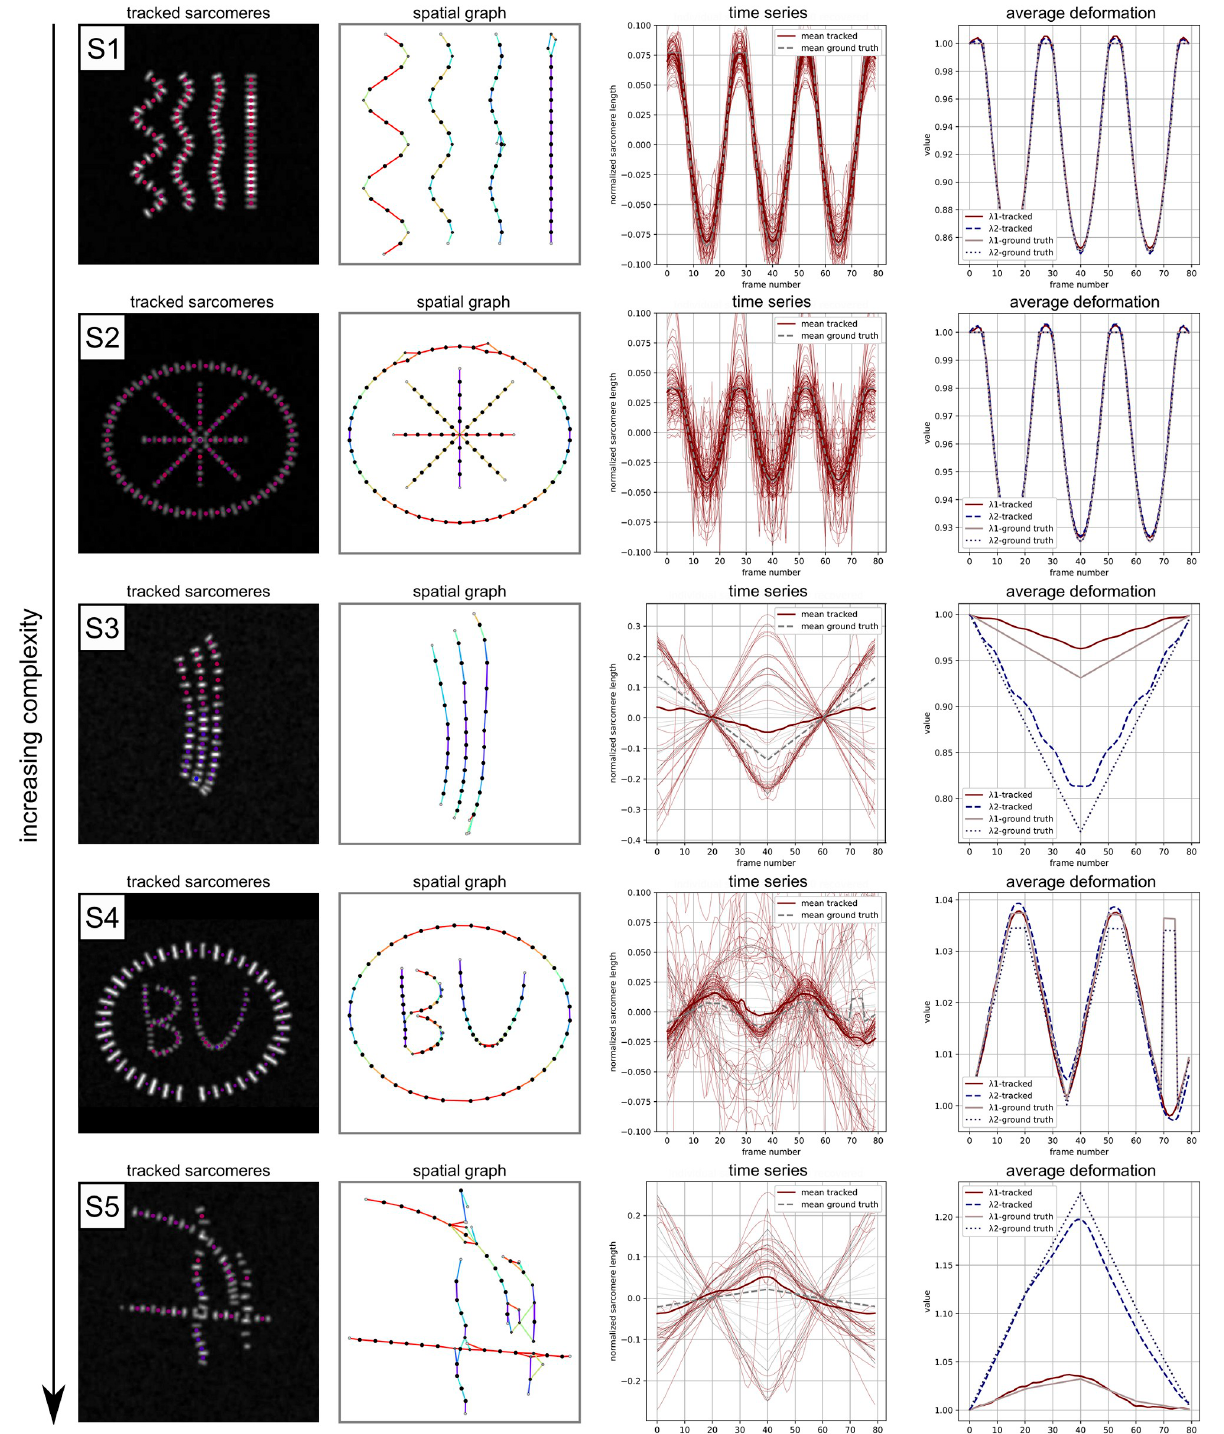
Fig 6. Example performance on synthetic data of increasing complexity with a known ground truth: Segmentation and tracking (marker color corresponds to sarcomere contraction in the illustrated frame); Constructing a spatial graph (line color corresponds to sarcomere orientation); Recovering individual time series data (both Sarc-Graph output and ground truth shown); Recovering average deformation behavior (both Sarc- Graph output and ground truth shown).